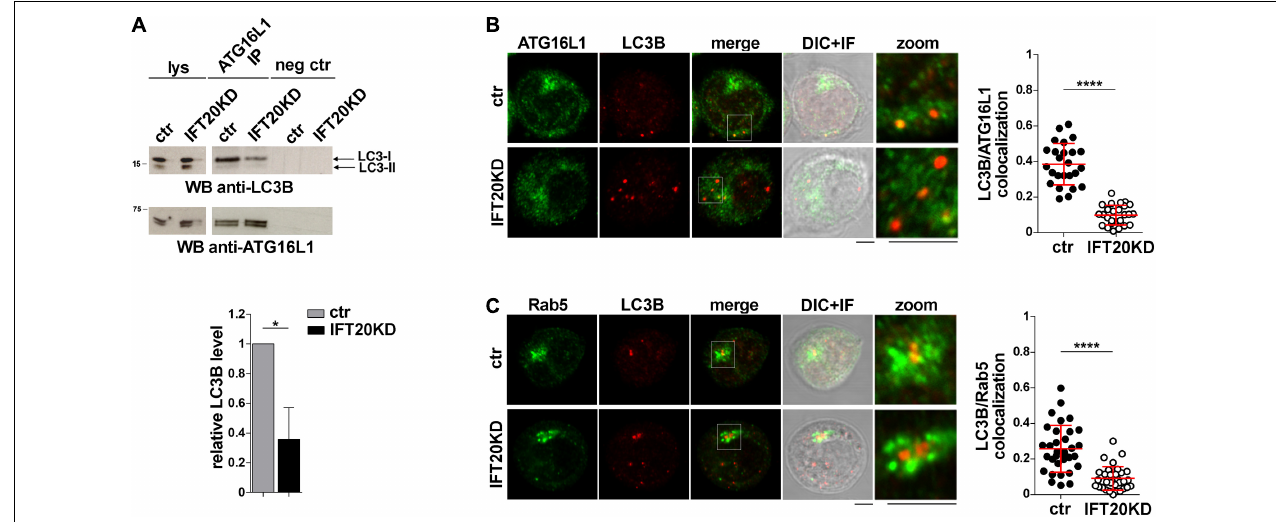
FIGURE 6 | IFT20 is required for LC3 recruitment to ATG16L1 at early endosomes. (A) Western blot analysis with anti-LC3B antibodies of ATG16L1-specific immunoprecipitates from lysates of control and IFT20KD Jurkat cells. Preclearing controls and total cell lysates are included in each blot (neg ctr). The migration of molecular mass markers is indicated. The quantification of the relative protein levels normalized to ATG16L1 (mean fold ± SD; ctr value = 1) is shown ( n = 3; mean ± SD; Student’s t -test). (B,C) Immunofluorescence analysis of ATG16L1 (B) or Rab5 (C) and LC3B in control and IFT20KD Jurkat cells. The graph shows the quantification using Mander’s coefficient of the weighted colocalization of LC3B and ATG16L1 (B) or Rab5 (C) in ctr and IFT20KD Jurkat cells reported as mean value/cell calculated on single dot LC3 + ( ≥ 25 cells/sample, n = 3; mean ± SD; Mann–Whitney test). Representative images (medial optical sections and the overlay DIC + IF) are shown. Scale bar: 5 µ m. * P < 0.05; **** P <